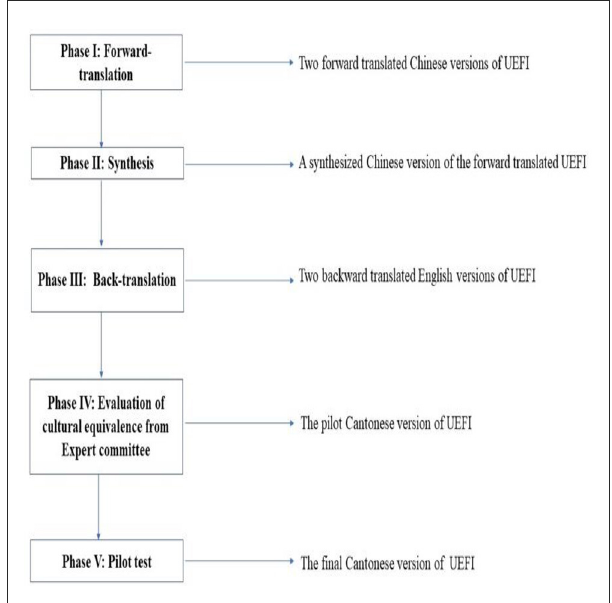
FIGURE1 Steps of UEFI translation and cross-cultural adaptation